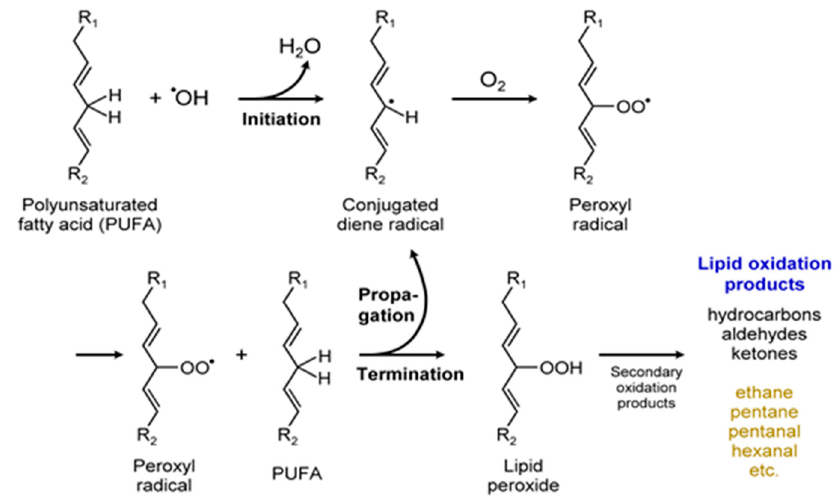
Figure 14. Volatile products of polyunsaturated fatty acid and lipid oxidation.